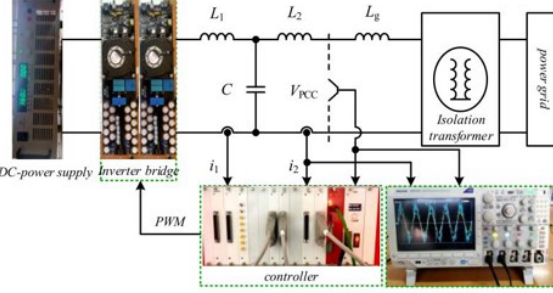
Fig. 18. Single-phase LCL grid-connected inverter experimental structure diagram.